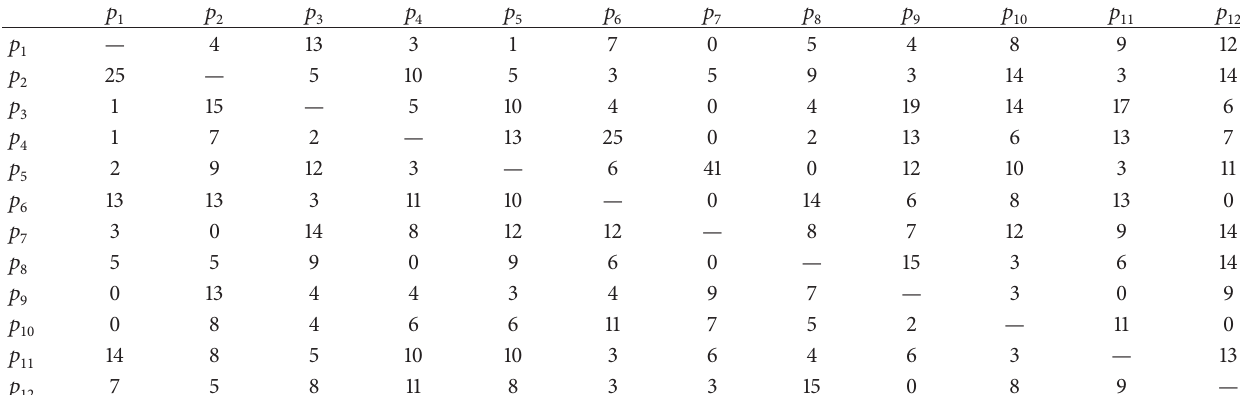
Table 4: Initial information of collaborative indicator 𝐶 2 of candidate units.